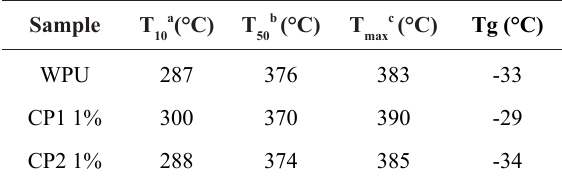
Degradation temperatures and glass transition ) of pure PU and CP1 and CP2 temperature (T g